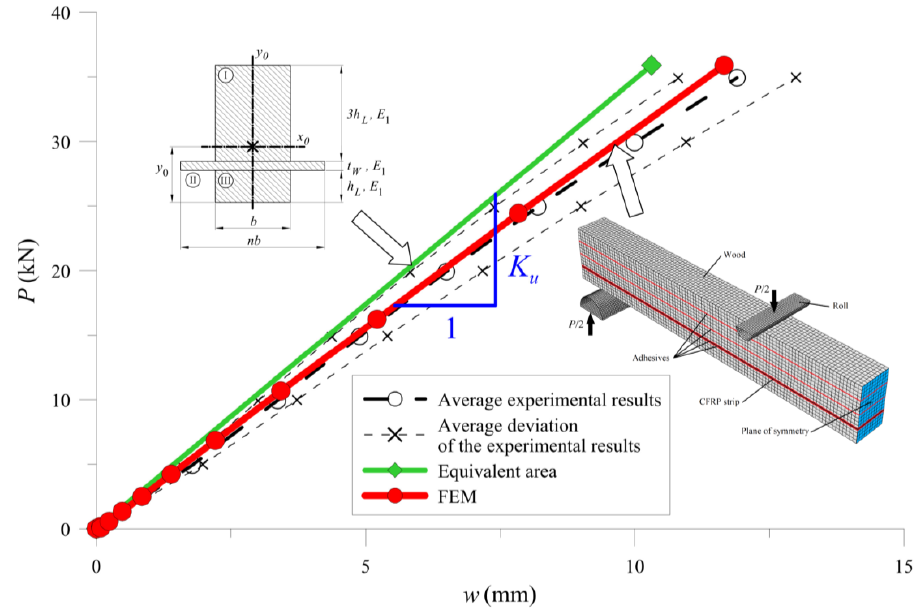
Figure 26. Results for BW-type of the sample.